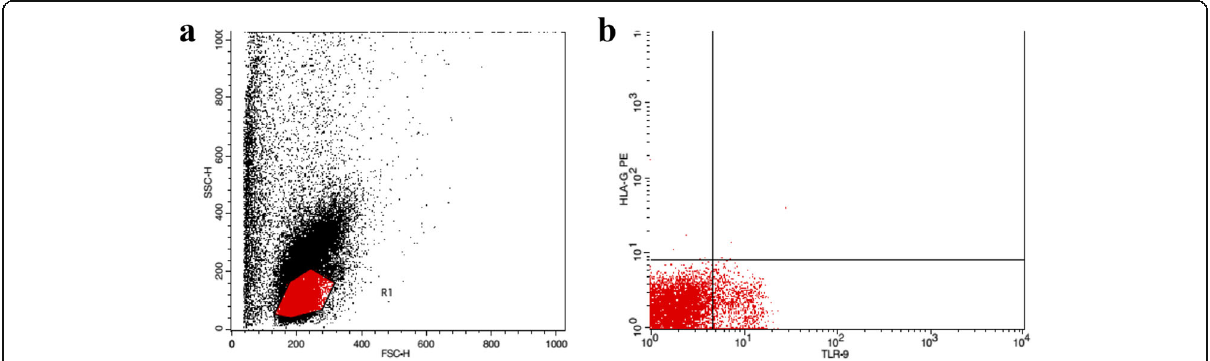
Fig. 2 Flow cytometry of one of the controls. a Gating of lymphocytes. b Expression of